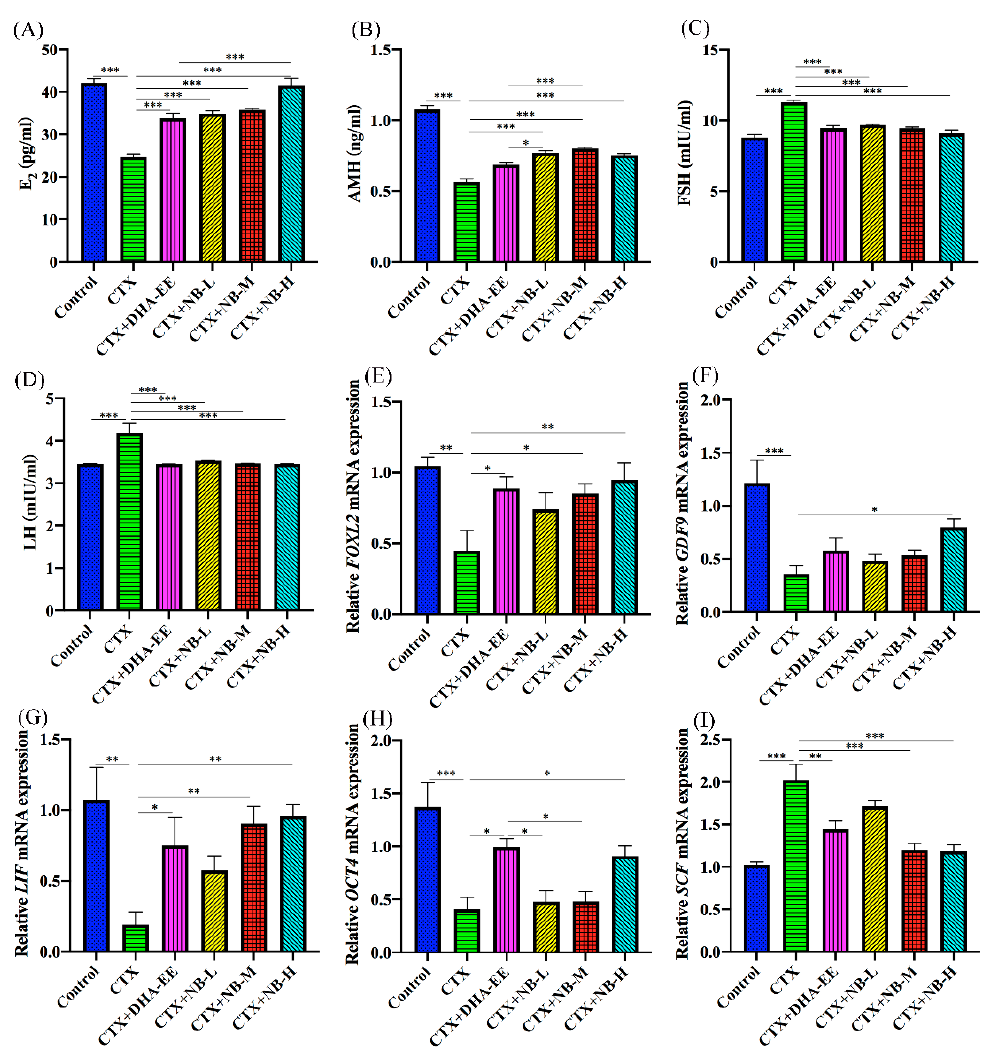
Figure 4. Effect of model and treatment on sex hormone levels and mRNA expression in mice. Sex hormone levels of E2 ( A ), AMH ( B ), FSH ( C ), and LH ( D ). mRNA expression levels of FOXL2 ( E ), GDF9 ( F ), LIF ( G ), OCT4 ( H ), and SCF ( I ) in mouse ovarian tissues, as determined by real-time PCR. * p < 0.05, ** p < 0.01, *** p <